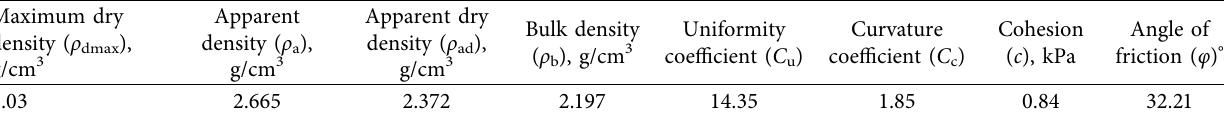
Table 2: Mechanical indices of the coal gangue.